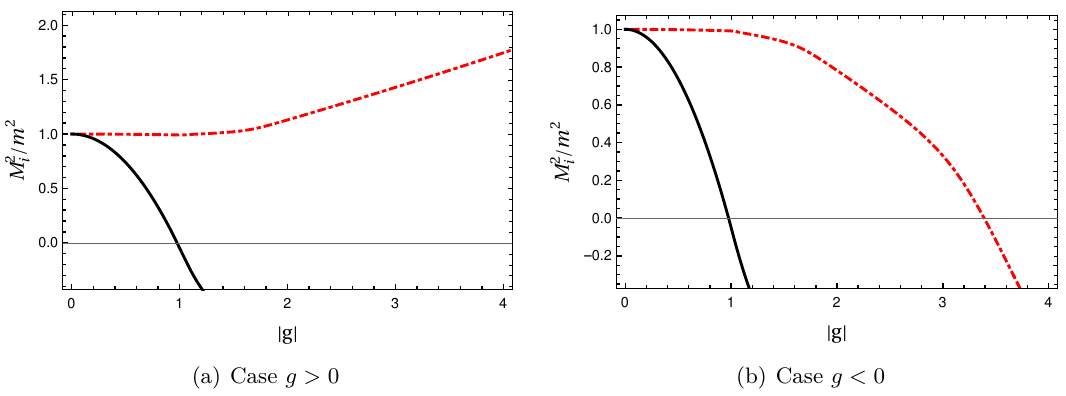
Figure 6 . The pole masses as a function of | g | for the Z 2 × Z 2 symmetric model. The solid line shows M 2 /m 2 and the dash-dotted line is for M 2 χ g φ = 0 . 5 | g | in this